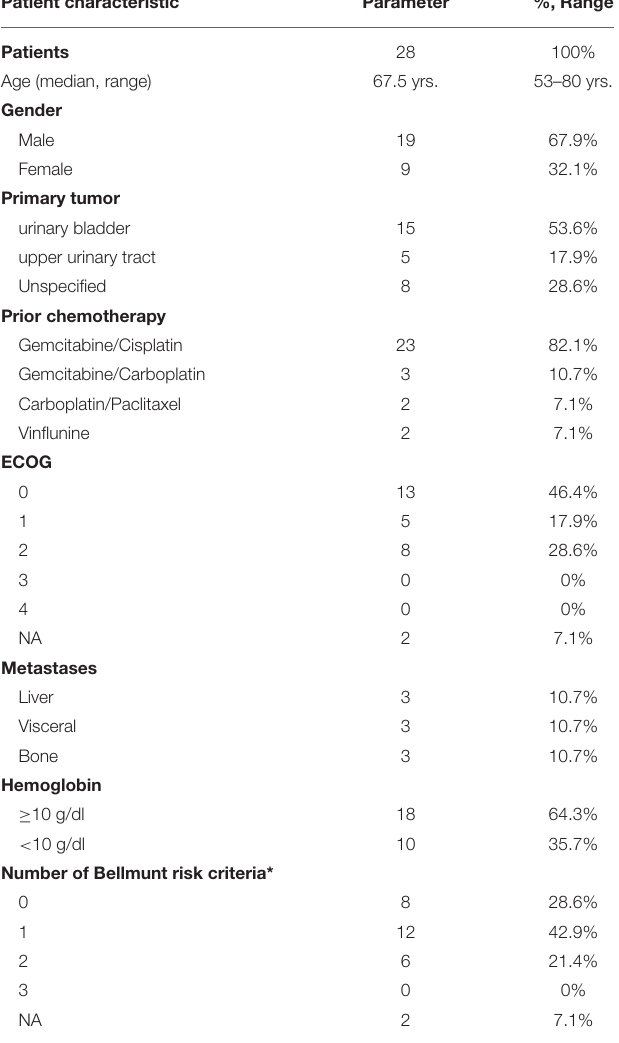
TABLE 1 | Patient characteristics for 28 Patients under checkpoint inhibitor monotherapy with Atezolizumab, Pembrolizumab, or Nivolumab (ECOG = Eastern Cooperative Oncology Group; NA = not available; * ECOG performance-status > 0, hemoglobin concentration < 10 g/dl, presence of liver metastases (16).